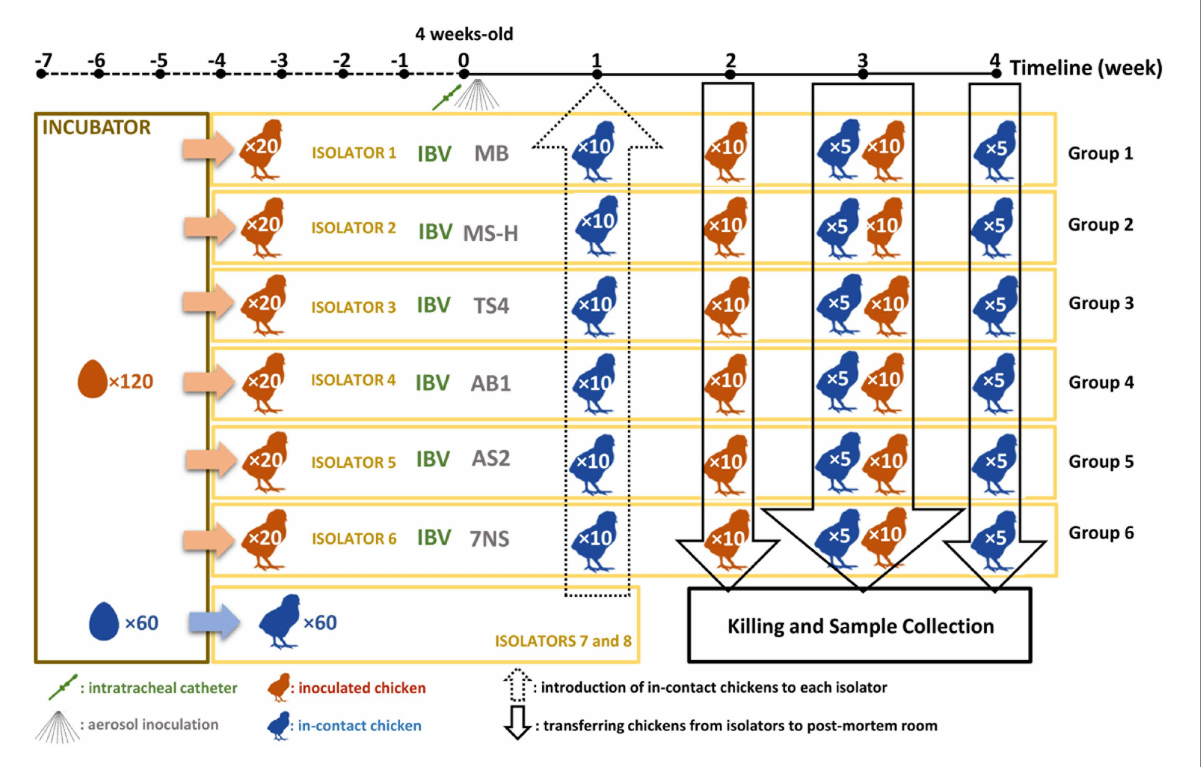
FIGURE 1 Schematic figure of the chicken experiment. A total number of 180 specific pathogen free (SPF) chickens were hatched. A total of 120 chickens (test chickens) were randomly divided into 6 isolators, while 60 in-contact chickens were randomly allocated into 3 separate isolators. At the age of 4-week, the test chickens inoculated with test substances. One week later, the in-contact chickens were moved into the test isolators (10 chickens per isolator). A total number of 60 chickens (10 from each group) will then be humanely killed 2 weeks later. After one more week, the rest of the test chickens (10 per group) as well as 5 in-contact chickens per group were humanely killed. One week later, the rest of the in-contact chickens (5 per group) were humanely